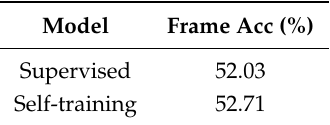
Table 2. Baseline